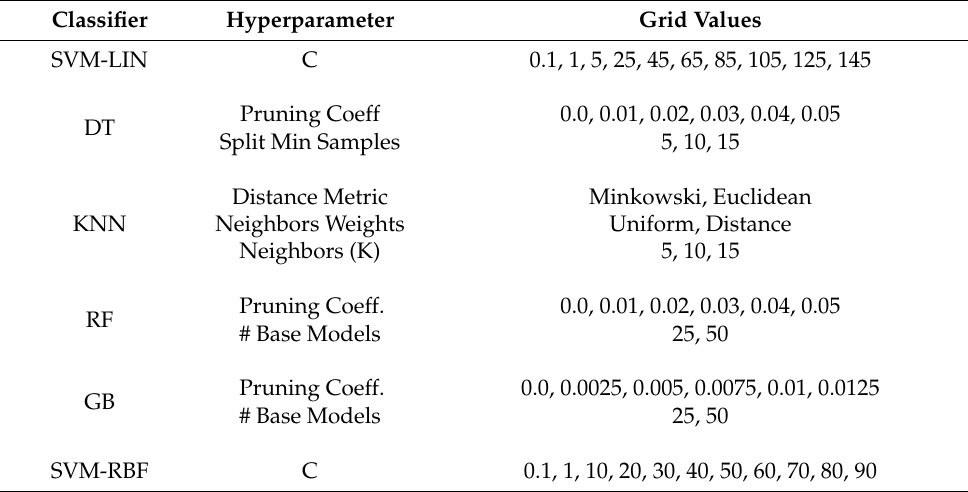
Table 2. Grid search values for classifiers’